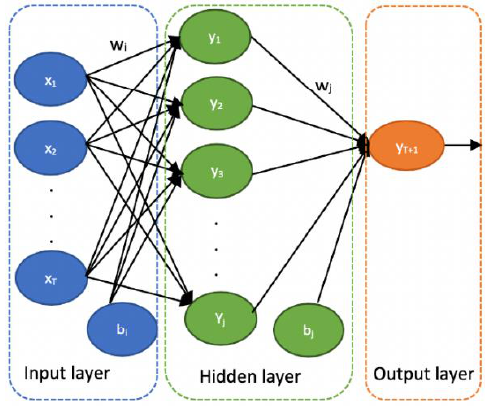
Figure 1. Architecture of applied Artificial Neural Network (ANN).